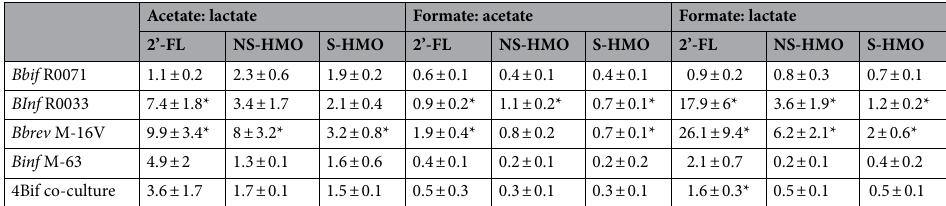
Table 1. Ratios of organic acids after 10 h fermentation. * p value < 0.05 versus theoretical ratio (acetate: lactate = 1.5, formate: acetate = 0.4, formate: lactate =